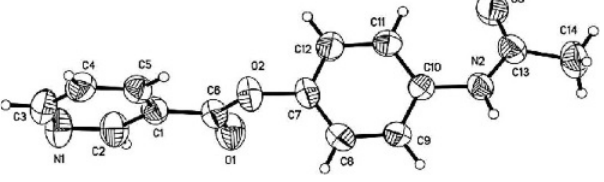
Table 2. Atomic coordinates and displacement parameters (in Å 2 )